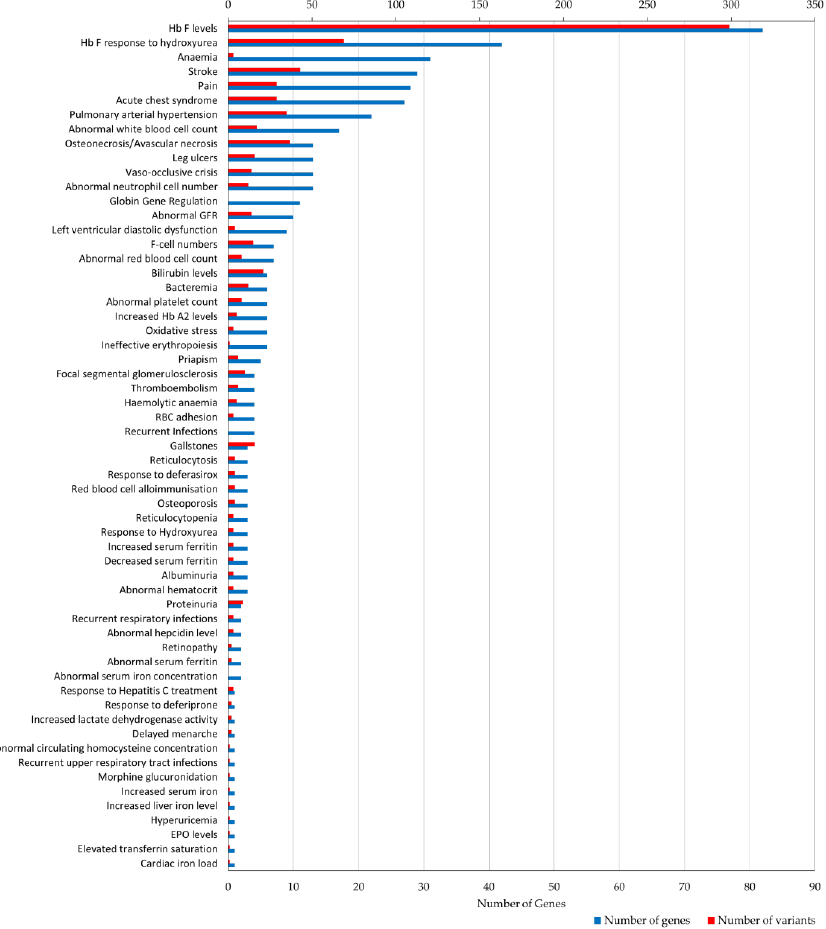
Figure 2. Number of gene and variant annotations per phenotypic term. Bar plot illustrates the number of genes (bottom x-axis, shown in blue) and variants (top x-axis, shown in red) assigned to each phenotypic term (total of 59) stored in IthaGenes. GFR, glomerular filtration rate; RBC, red blood cell; EPO, erythropoietin.